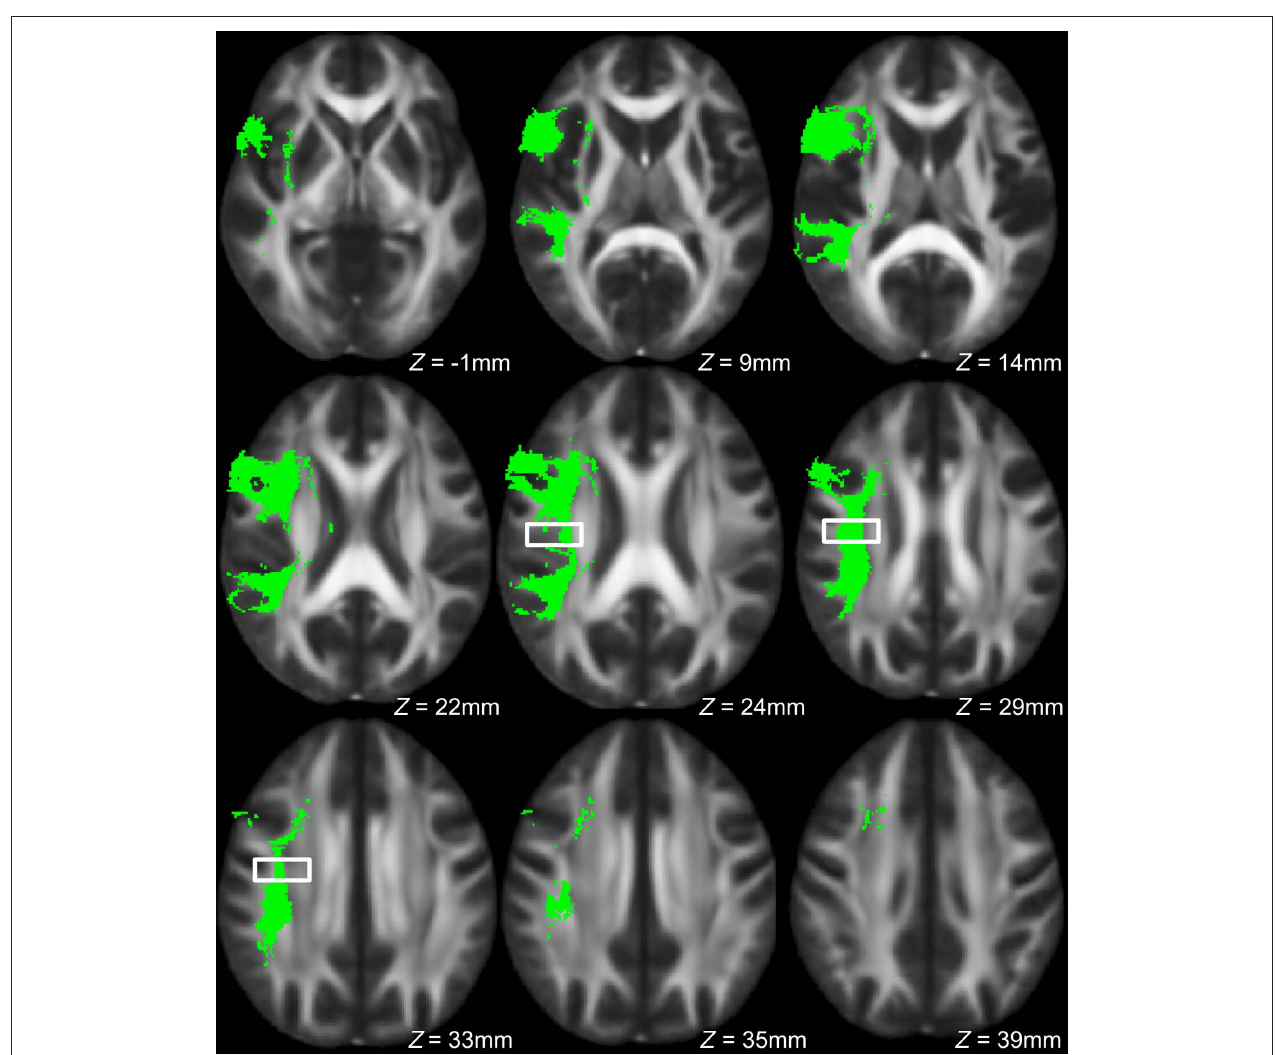
Figure 6 | Axial view of left dorsal AF across all subjects in green, with region showing significant between-group FA differences indicated by the